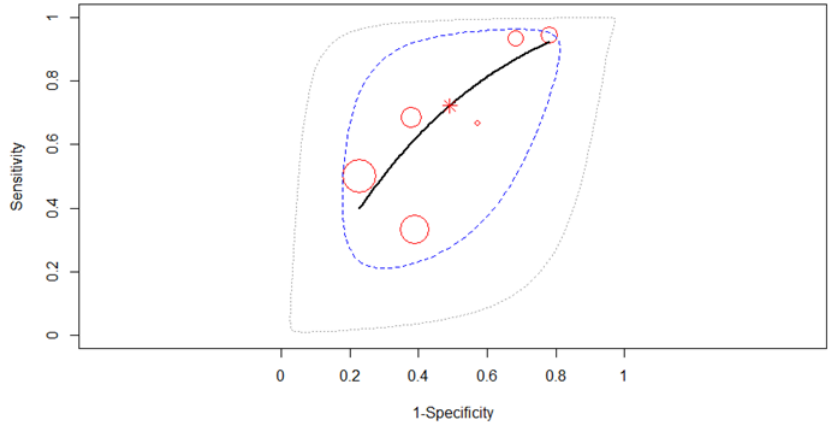
Figure 7. The SROC curve for T3 gastric cancer restaging.